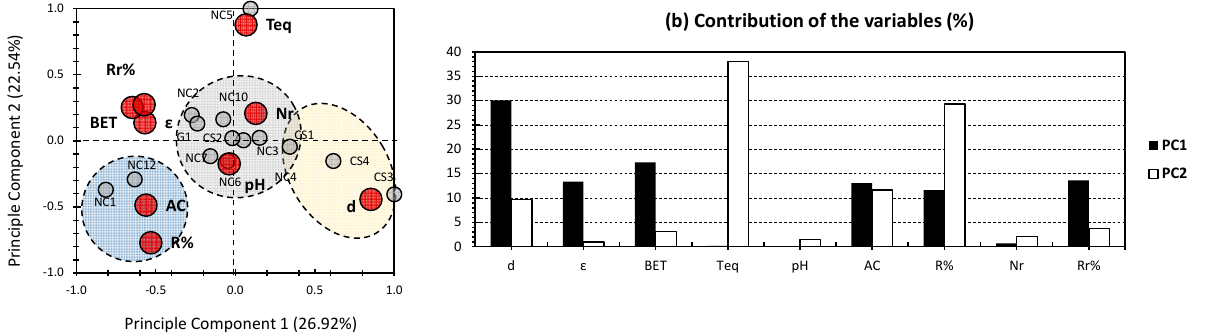
Figure 2. ( a ) PCA biplot for whole dataset, with the exclusion of NC8, NC9, and NC11. Gray bullets represent the individuals of the population (different investigated NC-, CS-, and G-based aerogels). Red bullets represent the variables (different employed physical/chemical and adsorption parameters). ( b ) Contribution of the variables.